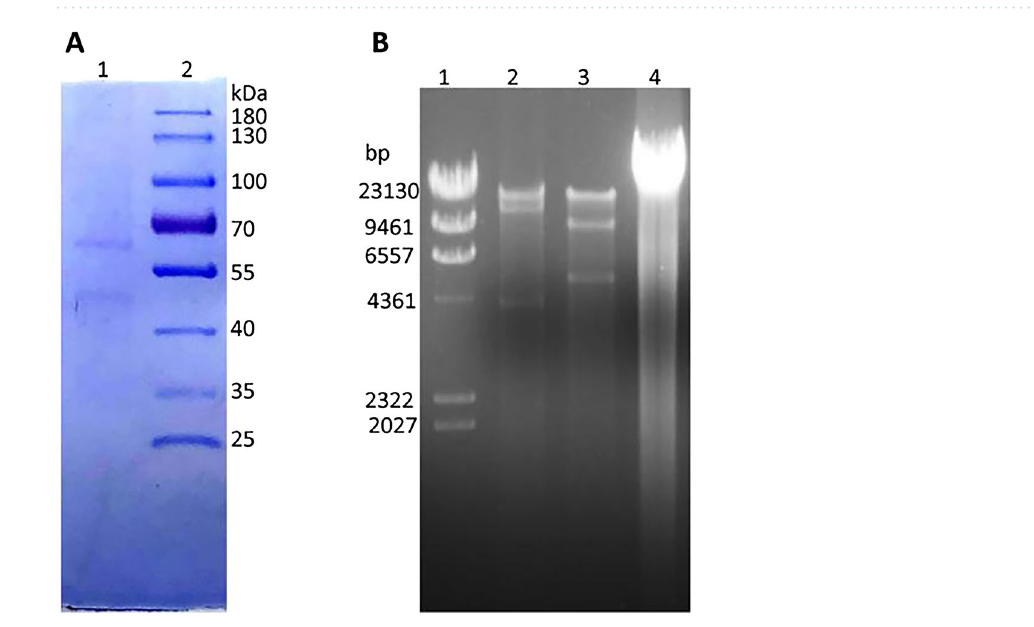
Figure 4. Major phage proteins and restriction endonuclease mapping of Abp95. ( A ) lane 1, SDS-PAGE of purified phage particles; lane 2, protein molecular weight marker. ( B ) Lane 1, DNA molecular weight markers Lambda DNA digested with HindIII; lane 2 and 3, Abp95 genomic DNA digested by XhoI and NheI, respectively; lane 4, Abp95 nondigested DNA. (the gel is